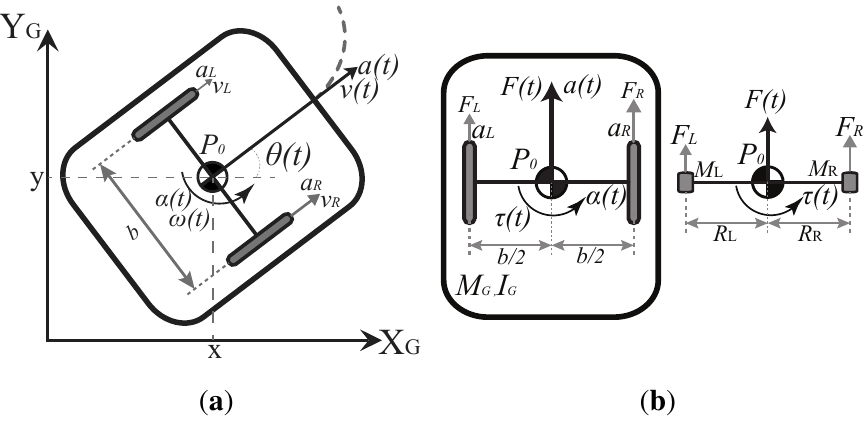
Figure 1. Differentially driven wheeled robot. ( a ) Kinematics; ( b )